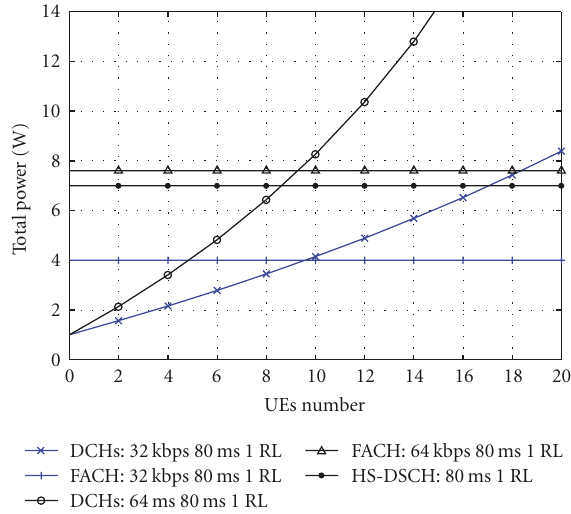
Figure 10: Node B’s Tx power for 95% coverage.